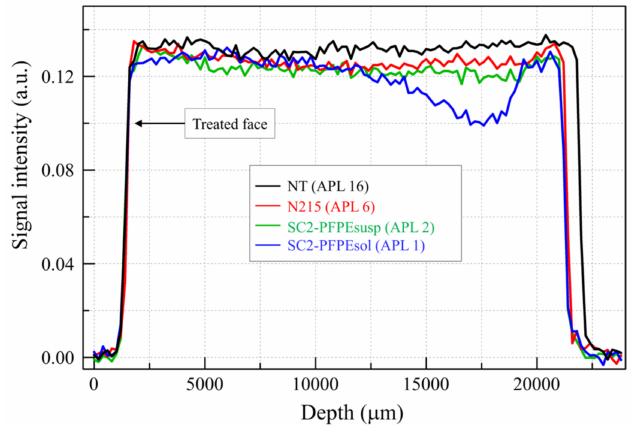
Figure 9. NMR signal intensity profile of water saturated coated and uncoated Lecce stone specimens acquired by NMR single-sided